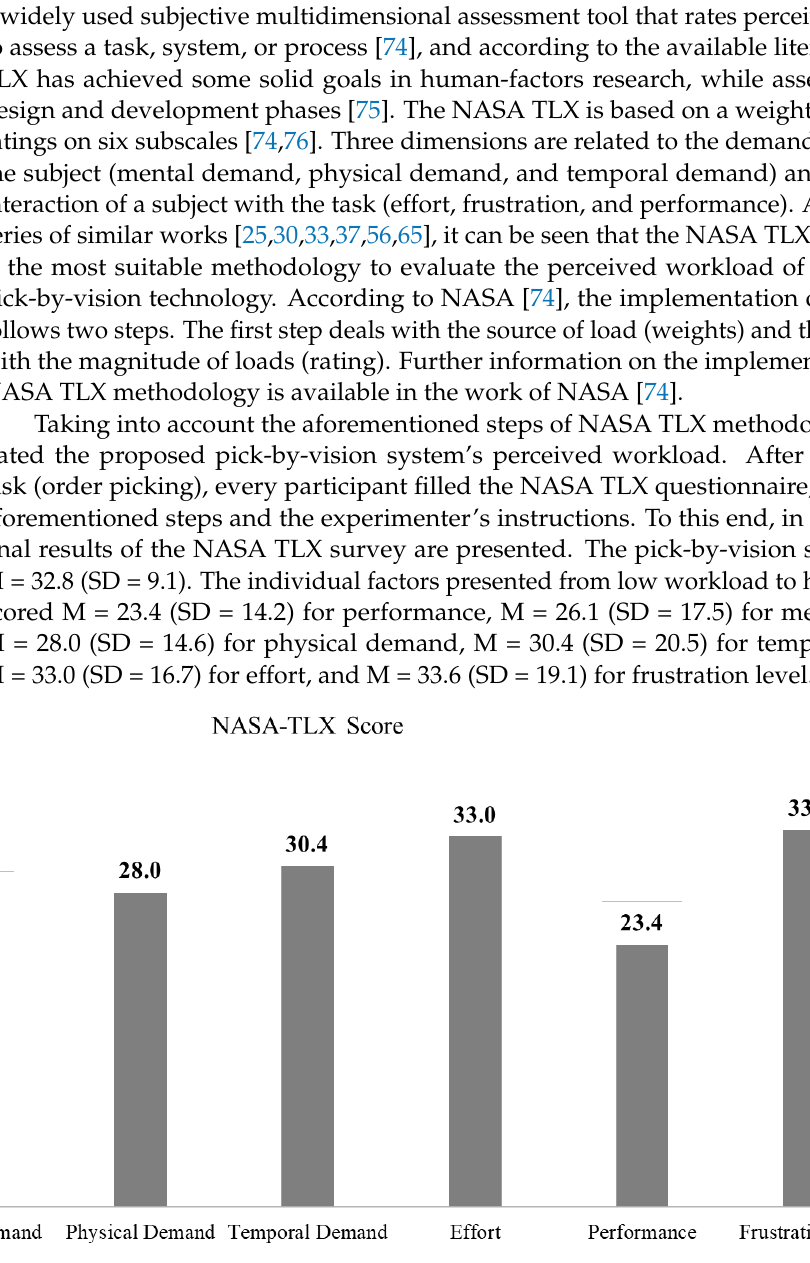
Figure 13. NASA TLX results for the proposed pick-by-vision system.